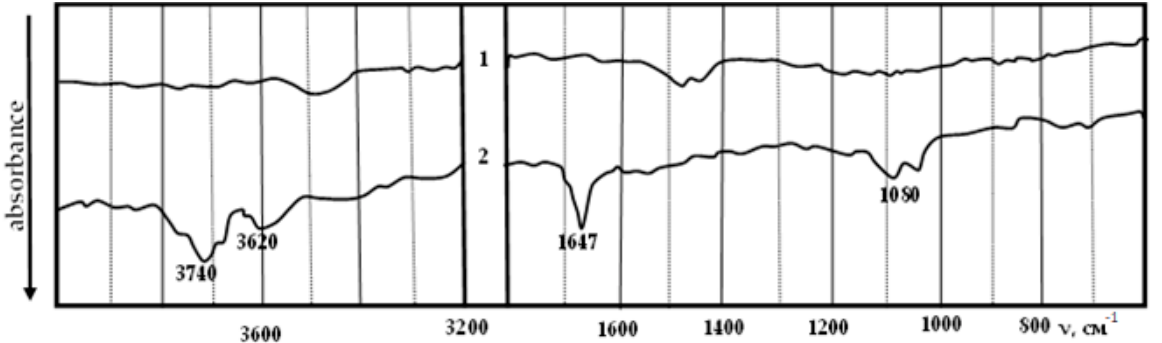
Figure 13. Infrared absorption spectra of slag suspension: without plasticizer; 1—without plasticizer, 2—with plasticizer.